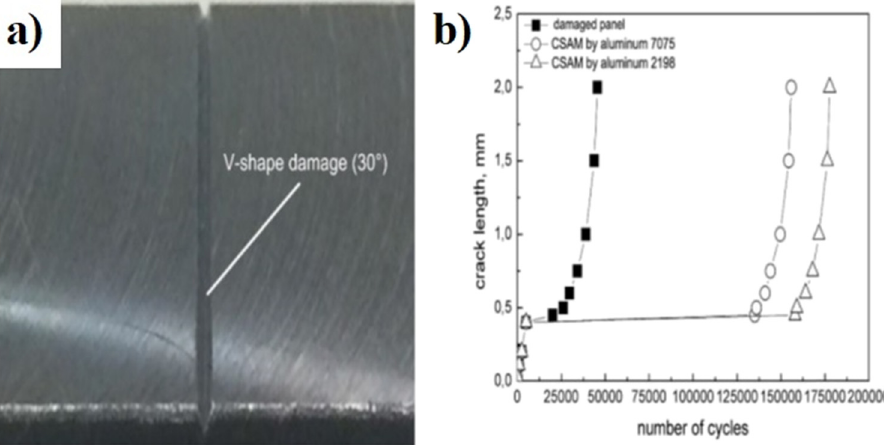
Figure 24: ( a ) Photograph of machining process made notch on Al alloy 2,099 panel surface and ( b ) crack length vs number of loading cycles [ 80 ]